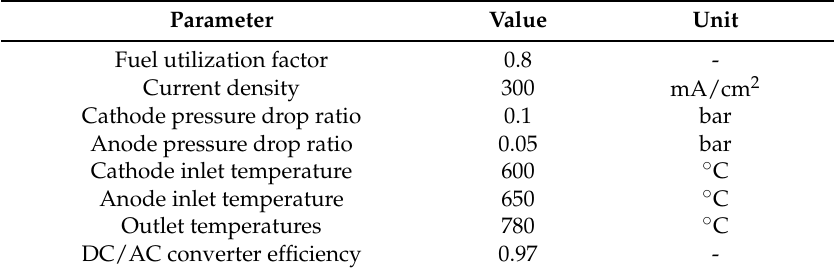
Table 3. The main SOFC parameters used in this study.